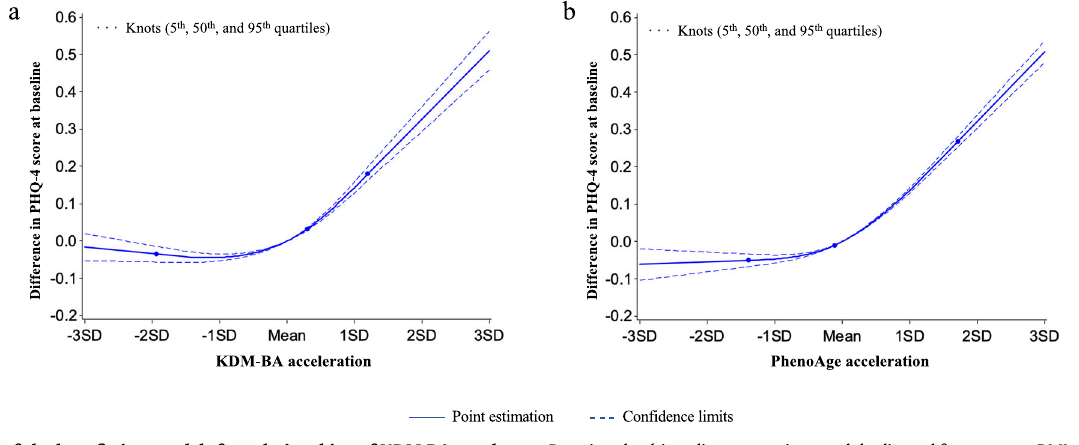
Restrictedcubicspline regression modeladjustedforage, sex,BMI category, race, smoking status (current/former/never), healthy alcohol intake status, healthy physical activity status, Townsend deprivation index, and prevalent hypertension, CHD, and diabetes. Source data are provided as a Source Data fi